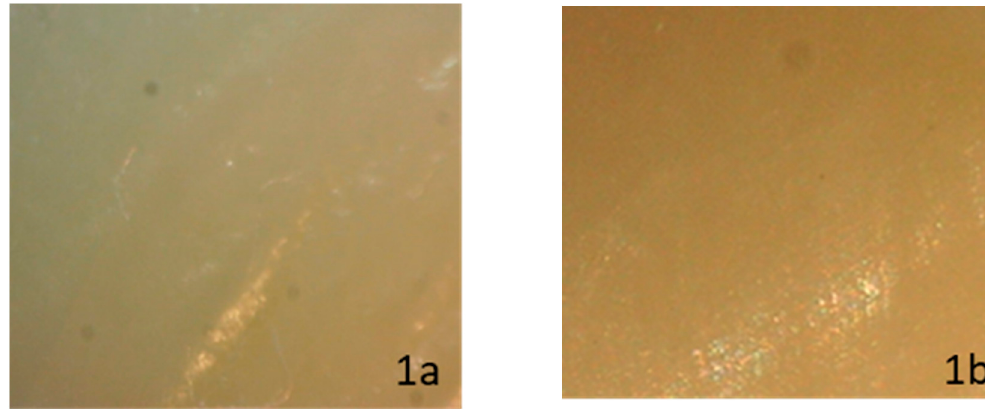
Figure 1. Stereomicroscopic evaluation showing no visible enamel topography changes before ceramic bracket bonding ( 1a ) and after laser debonding ( 1b ). The enamel conserved its normal glazed appearance.